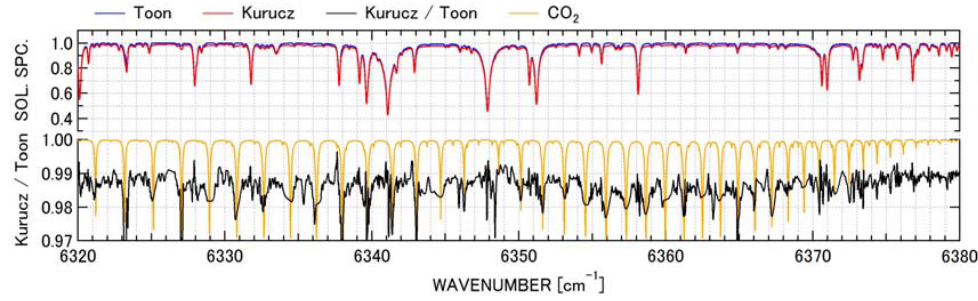
Fig. 5. The Kurucz’s and Toon’s solar spectrum and the ratio are plotted with CO 2 absorption lines. Fig. 5.